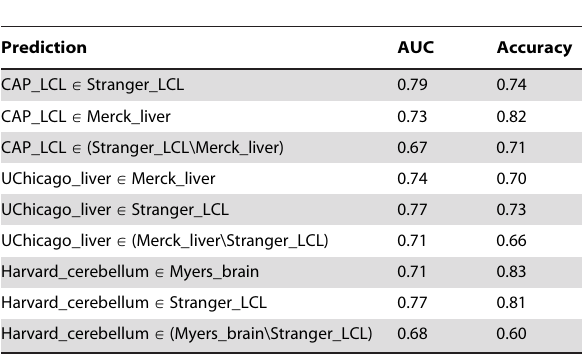
Table 3. Accuracy of random forest classifier